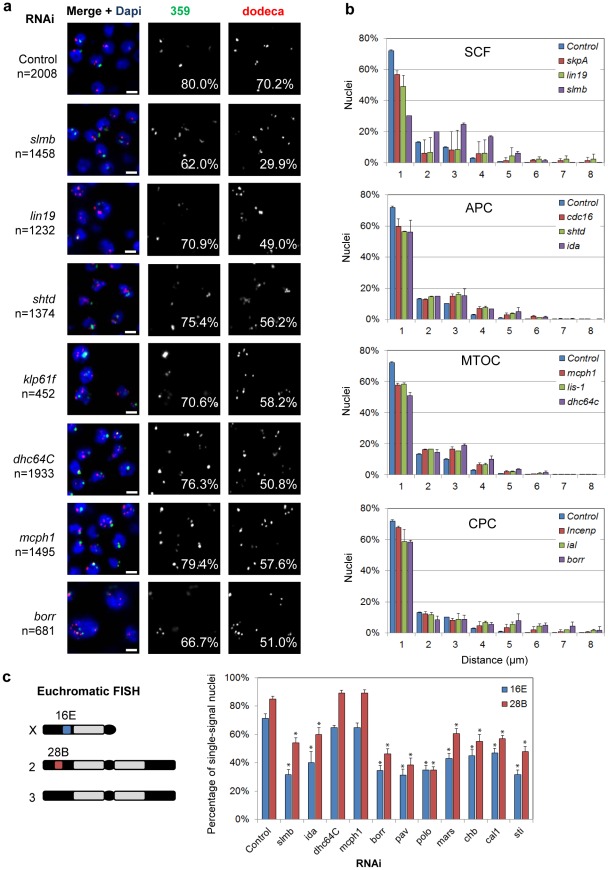
RNAi of candidate pairing promoters disrupts pairing.a, Representative FISH images are shown for RNAi knockdown of candidate pairing promoters (slmb, lin19, shtd, klp61f, dhc64C, mcph1, borr), where the number of FISH signals per nucleus is increased compared to control. The percentage of single-signal nuclei is noted for both 359 and dodeca. n denotes number of nuclei scored. Scale bars equal 5 µm. b, Relative frequencies of interhomolog distances (unpaired = two signals >1.0 µm apart) based on dodeca FISH ± SD for three tests. dsRNA targets are either grouped based on known interactions (SCF, APC, CPC) or localization patterns of the proteins they encode (MTOC). All significantly reduced the percentage of paired nuclei compared to control (P<0.05). c, Chromosomal targets of euchromatic FISH probes 16E and 28B and graph displaying the percentage of single-signal nuclei ± SD following RNAi. Asterisks denote a significant reduction from control (P<0.05). A minimum number of 100 nuclei were scored for each dsRNA.